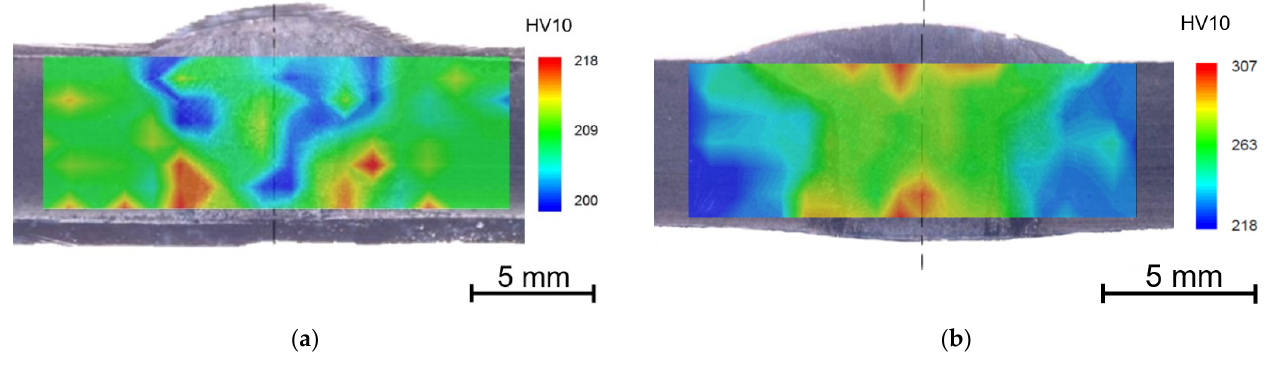
Figure 8. Hardness maps of the annealed weld joint after aging ( a ) 650 °C/7,560 h, ( b ) 675 °C/7, 560